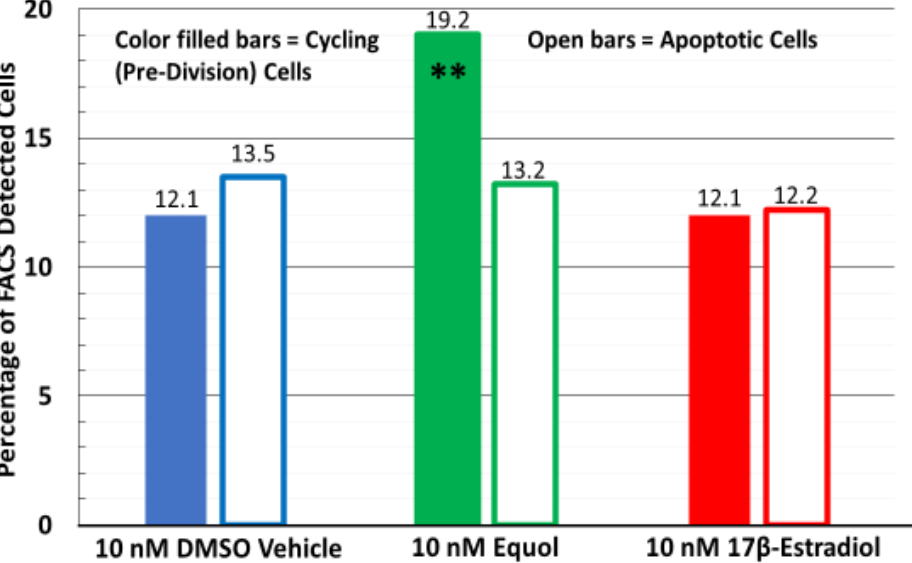
Figure 5. FACS analysis in long-term (eight-week) tissue cultures quantifying cell cycle and apoptosis as the percentage of cells by treatment (after four days of exposure). Each bar represents 20,000 cells examined per data file. ** = Significantly greater compared to DMSO or 17 β -Estradiol levels ( p < 0.001) There was no significant difference in apoptotic cells among the treatments at the threshold level of p < 0.001.